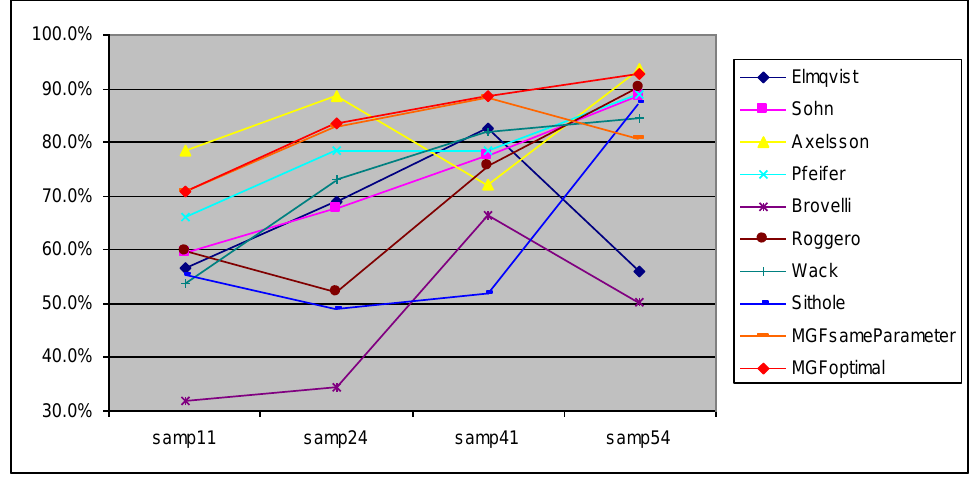
Figure 4. Accuracies of nine ground filters on sites with steep slope and trees.